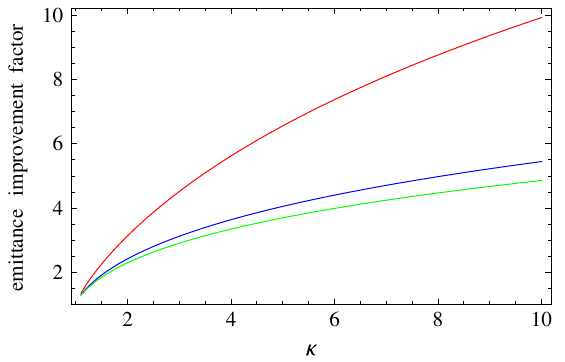
FIG. 18. Summary of improvement factors in the theoretical minimum emittances for TME (red), AME (blue), and EME (green) lattices, resulting from the above optimal profiles.